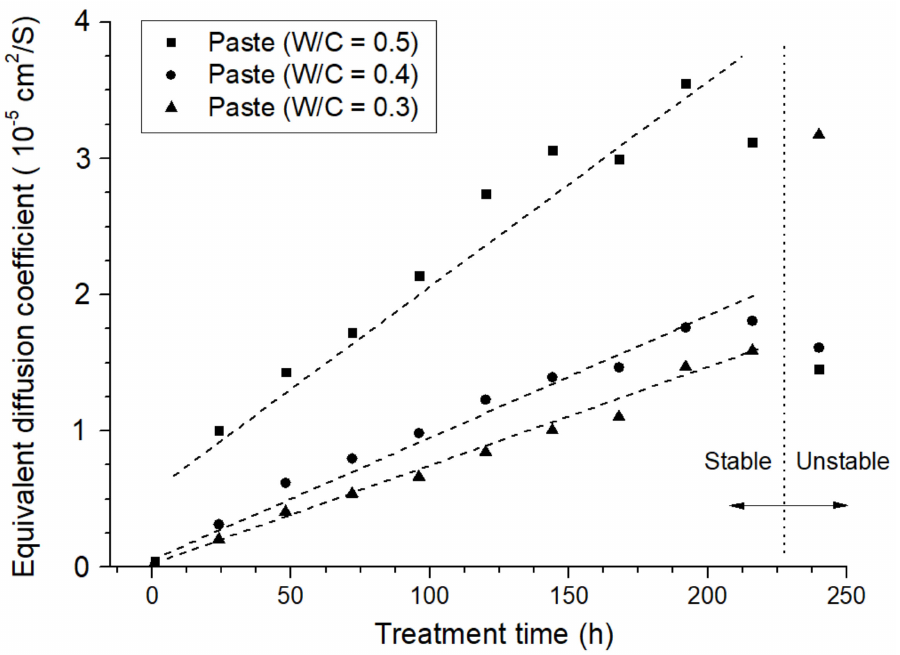
Figure 7. The time-dependent variation in the equivalent diffusion coefficient of the anode samples prepared with neat cement